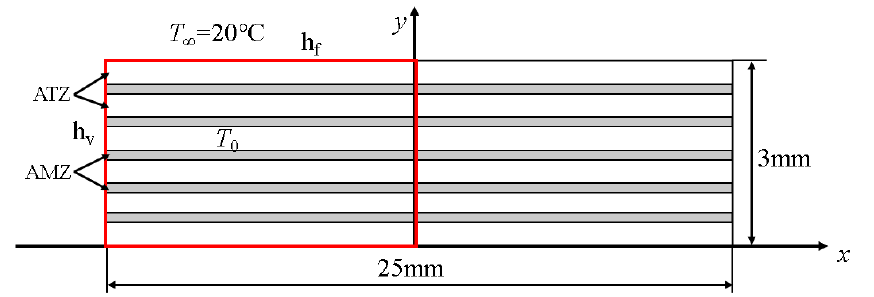
Figure 9. Thermal shock geometric model sketch of the Al 2 O 3 /ZrO 2 -laminated ceramic specimen.